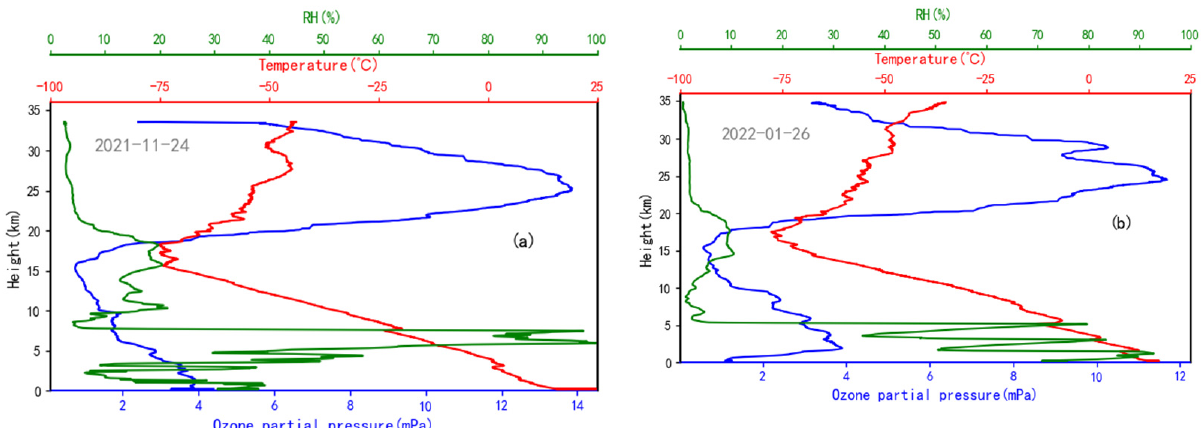
Figure 1. Profiles of ozone partial pressure, temperature, and humidity at the Shaowu observation station. 24 November 2021 ( a ) and 26 January 2022 ( b